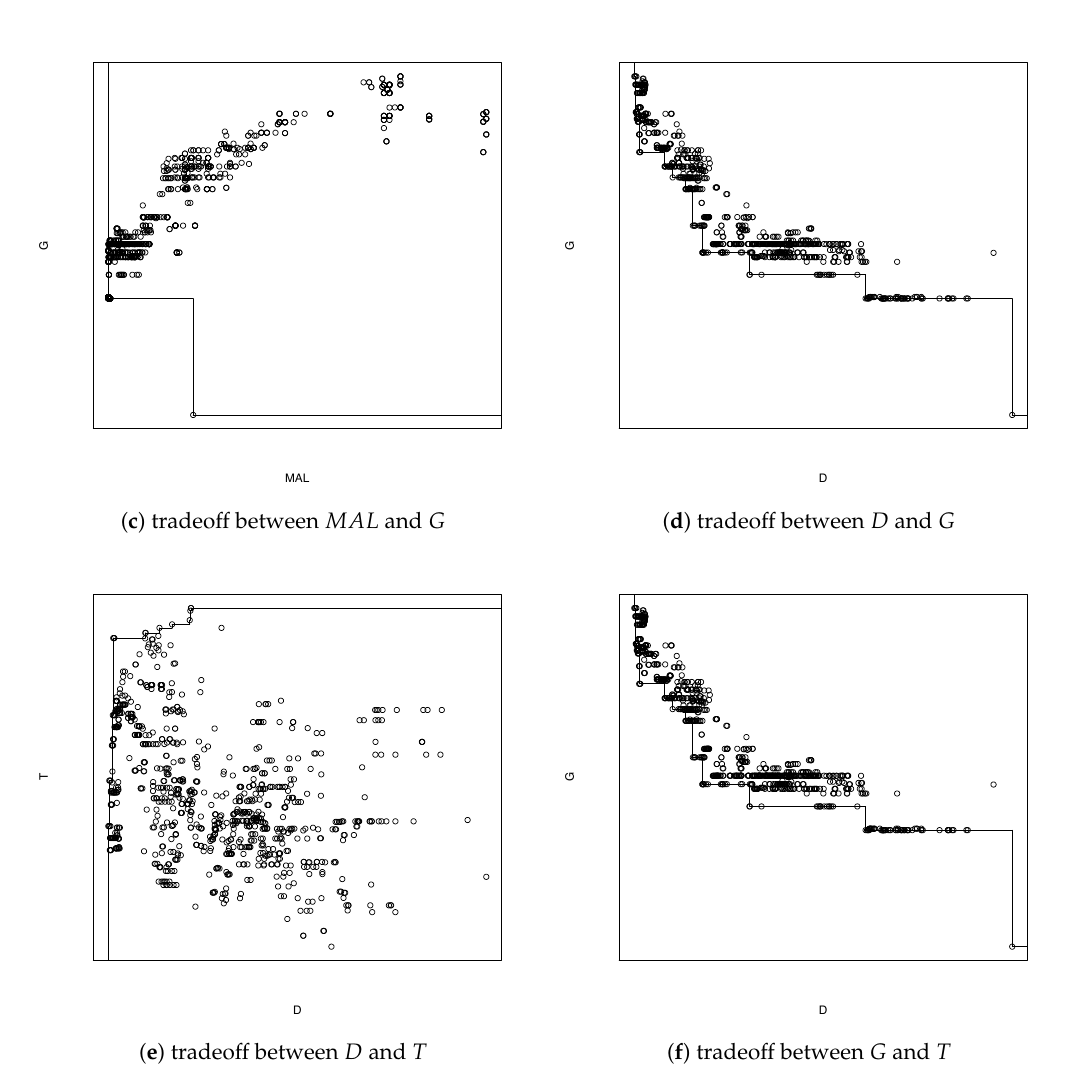
Figure 4. Pareto fronts for the “Metropolitana”